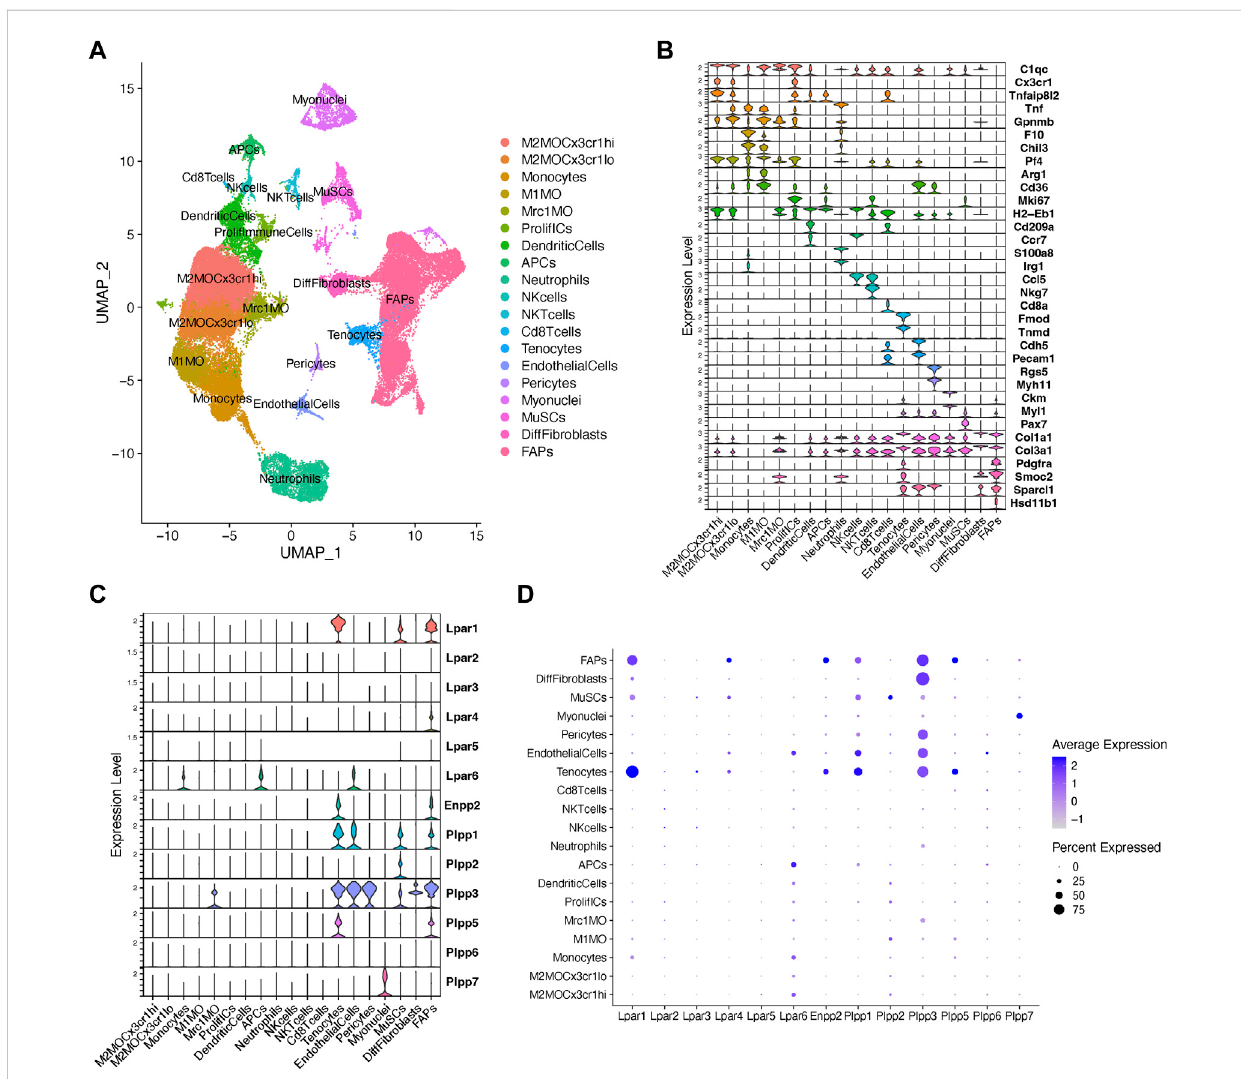
FIGURE 2 Analysis of Lpar-Enpp2-Plpp gene expression at single-cell resolution. (A) Uniform manifold approximation and projection (UMAP) plot of scRNA- seq public data (Oprescu et al., 2020) showing 19 distinct cell lineages in single cells across skeletal muscle homeostasis and regeneration. Detected major cell lineages were colored by the predominant cell type(s) that composes each cluster. (B) Violin plots showing the expression level of several marker genes across the different populations depicted in (A) . (C) Violin plots showing the gene expression level of LPA receptors, Enpp2 , and Plpp family members across the different populations or cell clusters. (D) Dot plot showing gene expression levels of LPA receptors, Enpp2 , and Plpp family members. Dot plots help to visualize two values across two dimensions: color and size. The color gradient of the dot approximates average gene expression (light grey: low expression; navy blue: high